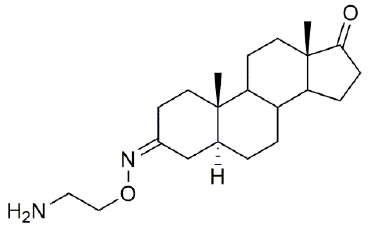
Figure 16. Istaroxime.